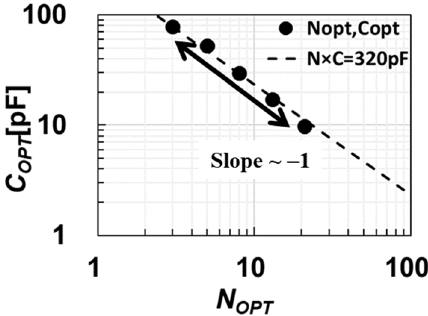
Ω and V OC = 0.5–2.0